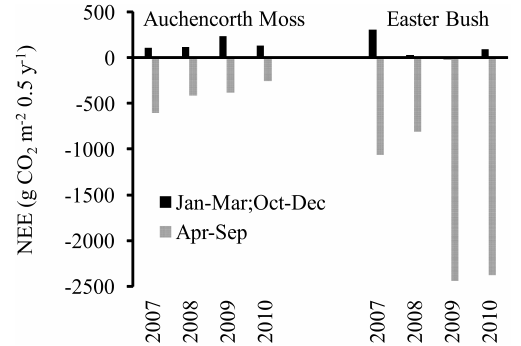
Fig. 6. Cumulative net ecosystem exchange of CO 2 (NEE) for the cold period (January–March and October–December) and the warm period (April–September) at Auchencorth Moss and Easter Bush.